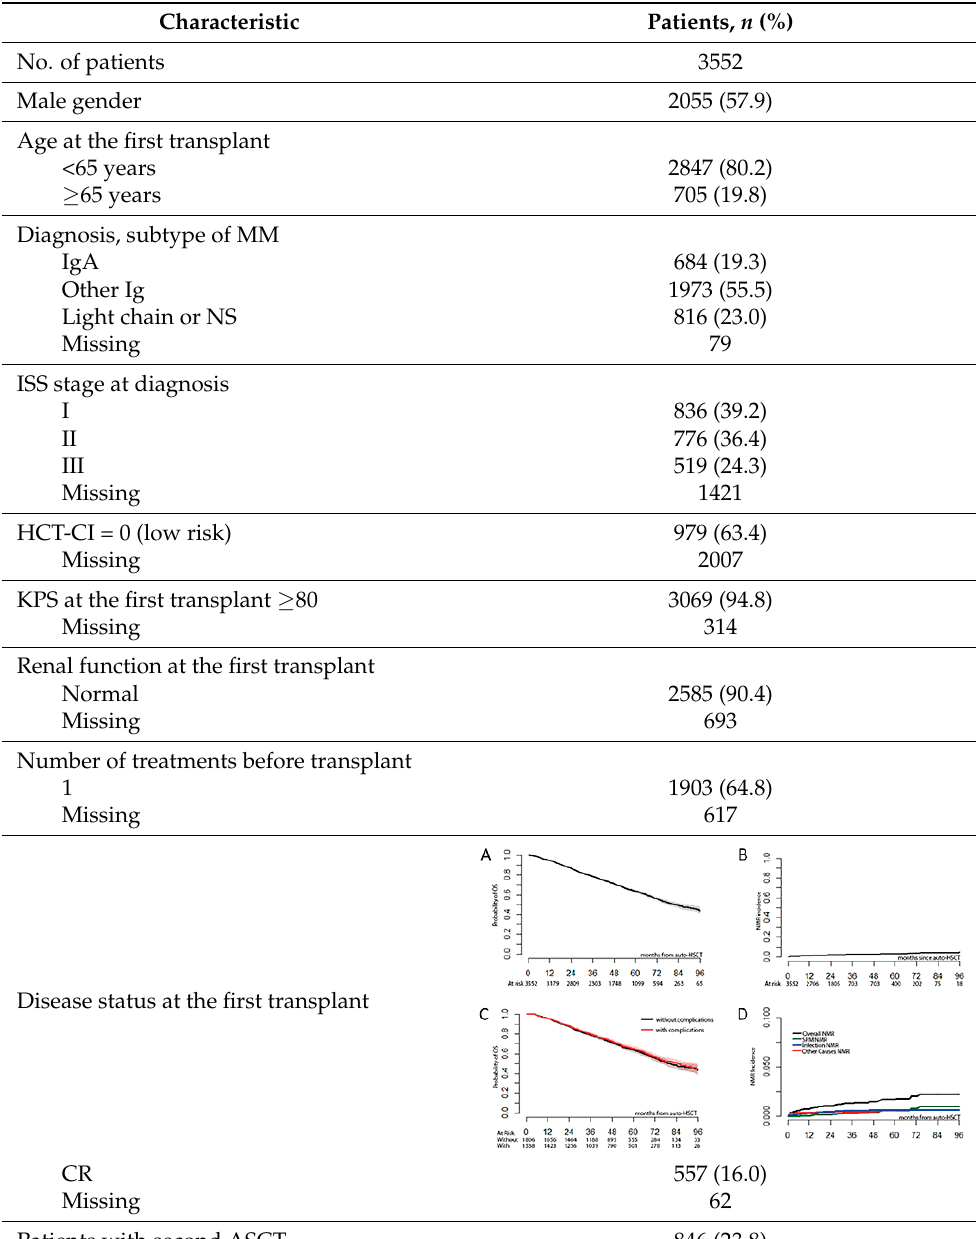
Table 1. Patients’ demographics, disease and transplantation